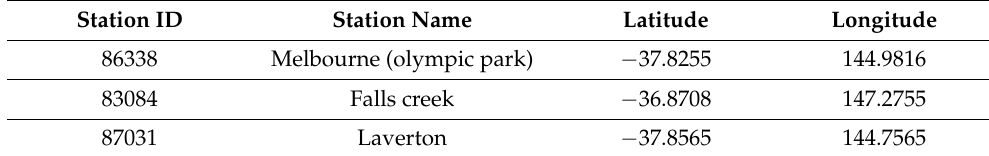
Table 7. Weather station details in the state of